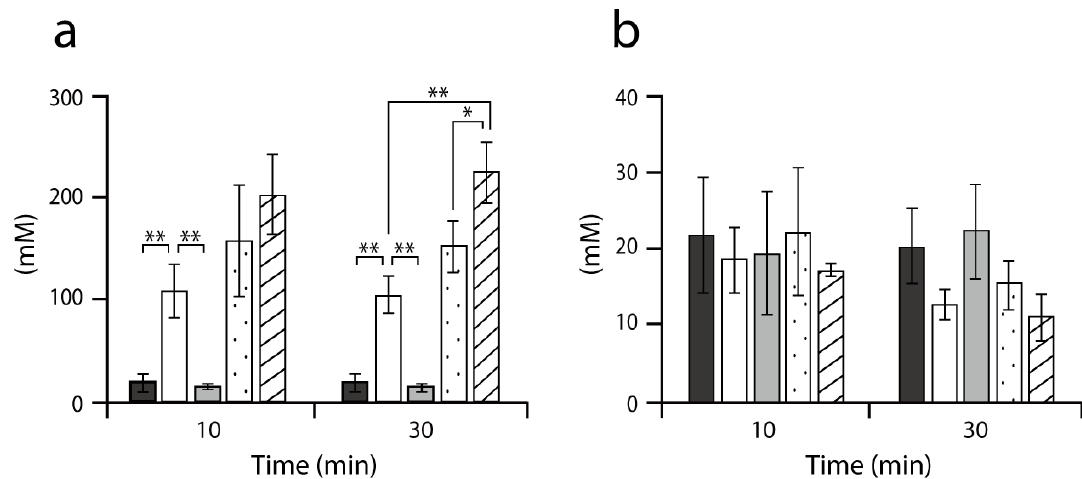
Figure 1. Intracellular accumulation of alanine ( a ) and glutamic acid ( b ). After incubation of strains MG1655 (black), MG1655 ∆ alaE (white), MG1655 ∆ dadA (grey), MG1655 ∆ dadA ∆ alaE (stippled), and MLA301 ∆ alaE (hatched) in minimal medium containing 6 mM Ala-Ala, intracellular fractions were recovered by the silicone oil method, as described in materials and methods. Intracellular alanine and glutamic acid were determined by HPLC. Data are means ± standard deviations from three separate experiments. Asterisks indicate statistically significant differences (unpaired Student t -test, ** < 0.01, * < 0.05).